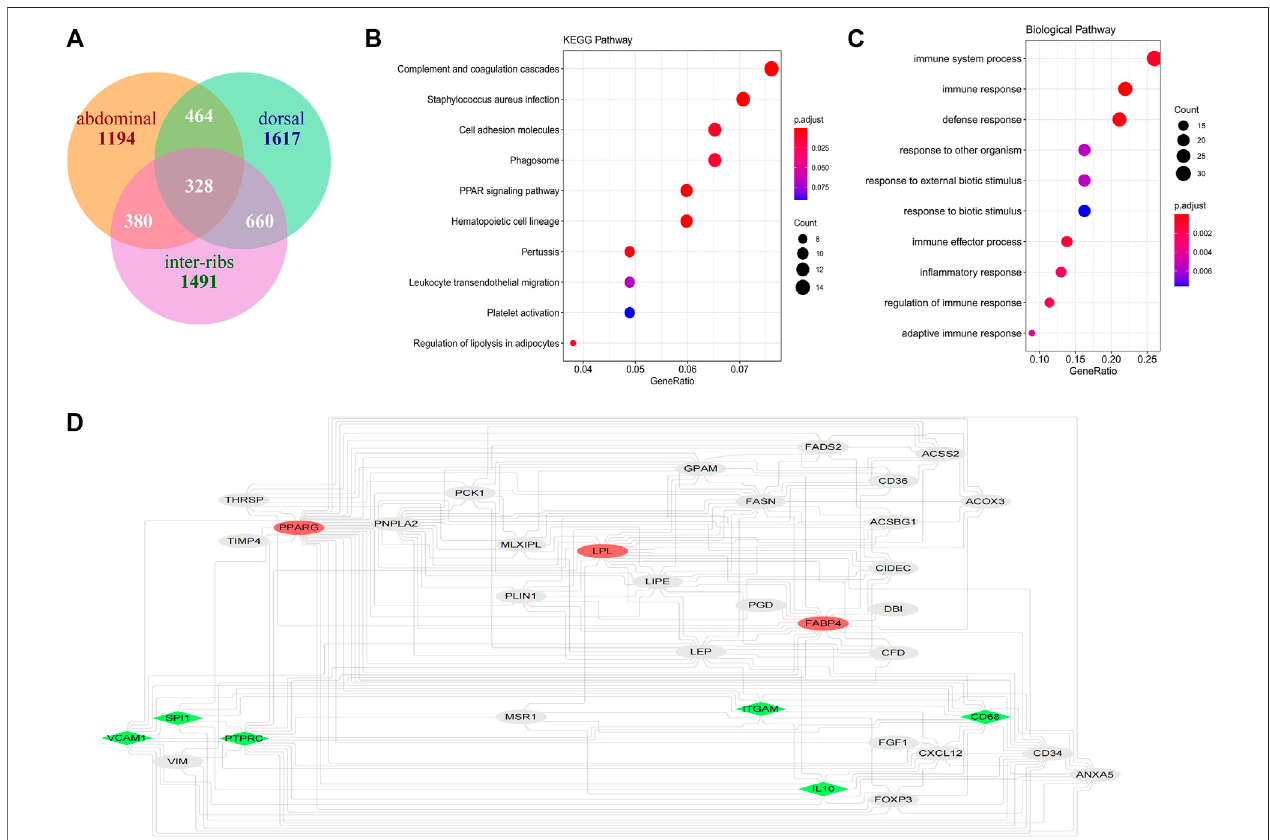
FIGURE 8 | Identi fi cation of hub genes in subcutaneous fat. (A) Intersection of genes signi fi cantly related to inter-ribs, abdominal and dorsal subcutaneous fat; (B) KEGG analysis of the 328 shared genes of the three subcutaneous fat; (C) Biological pathway analysis of the 328 shared genes of the three subcutaneous fat; (D) Identi fi cationofthecommonhubgenesofthethreesubcutaneousfat(theredonesaretheseedgenes,andthegreenonesarethehubgenesthatbothinteractwiththe seeds calculated by MCC and Degree algorithms).